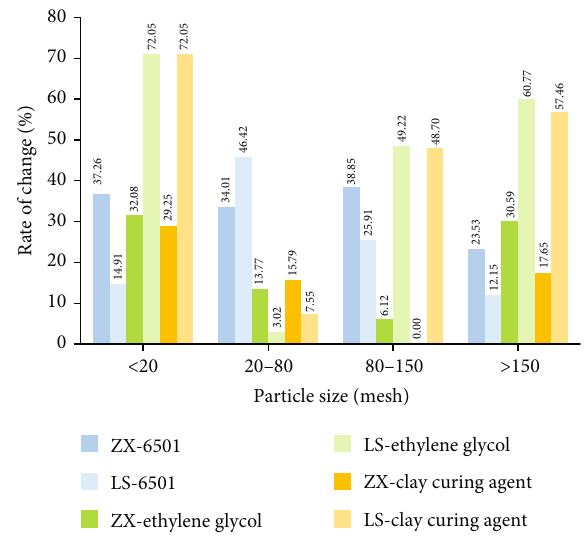
Figure 12: Modi fi cation e ff ects of di ff erent active agents on coal fi